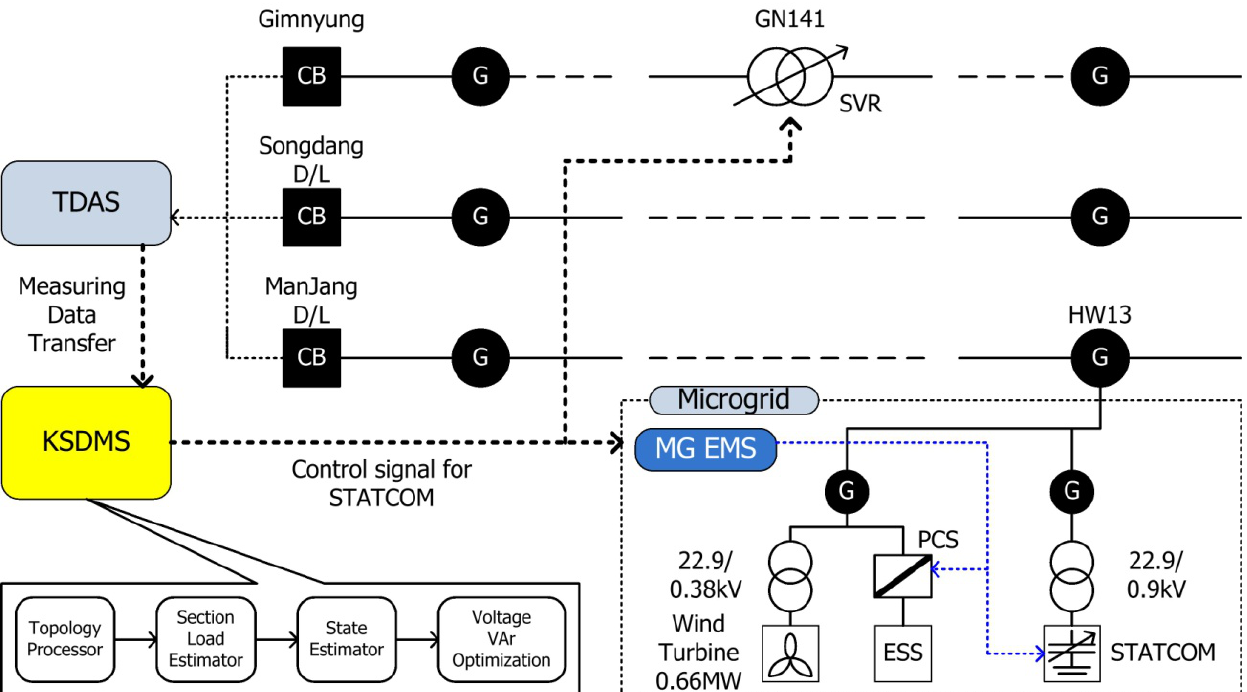
Figure 12. One-line diagram of the test